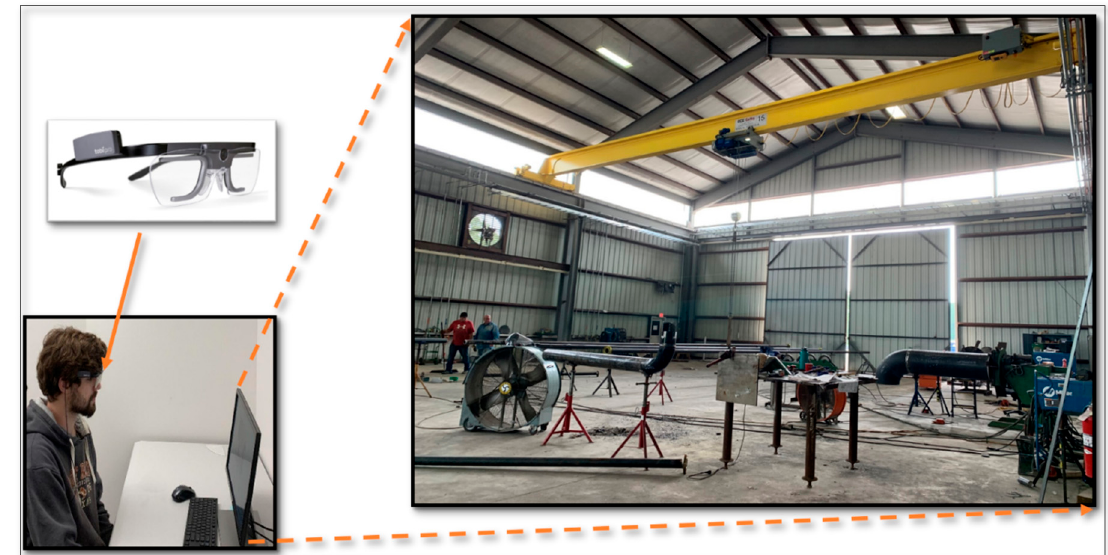
Figure 3. Lab setting for the experiment.